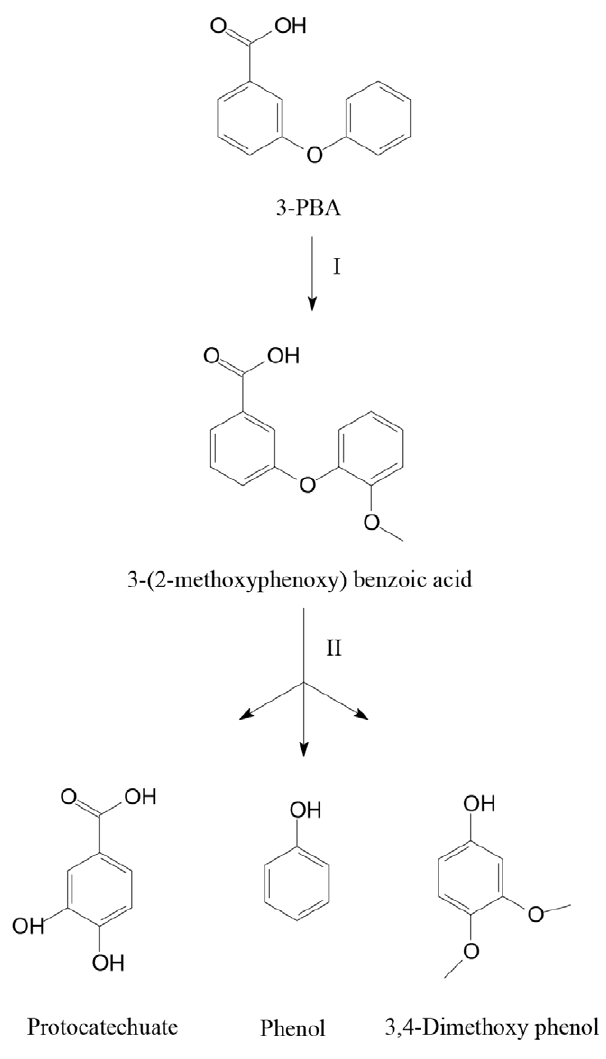
Figure 5. The proposed pathway for the 3-PBA degradation by strain DG-02. I, oxidization; II, phenyl ether